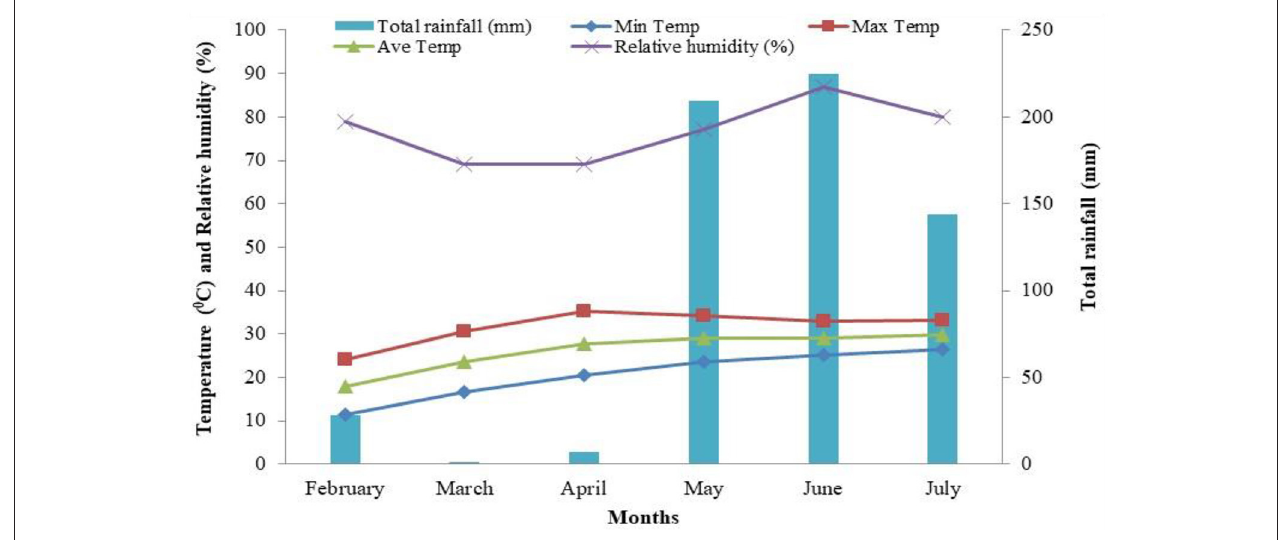
FIGURE 1 | Monthly average temperature (minimum, maximum, and mean), relative humidity (%), and rainfall (mm) during the experiment.